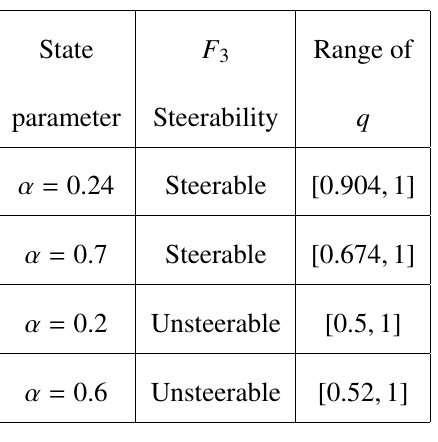
Table 1: Modified QKD protocol with ϵ 1 = 0 . 15 , ϵ 2 = 0 . 02563 is considered. For some specific values of state parameter α, range of the other parameter q is specified for which corre- sponding state is useful for secure key generation in this modi- fied QKD protocol. The second column in the table indicates whether the state used in the protocol violates CJWR inequality or not. The last two instances point out the fact that initially F 3 unsteerable states can also be used for the modified QKD